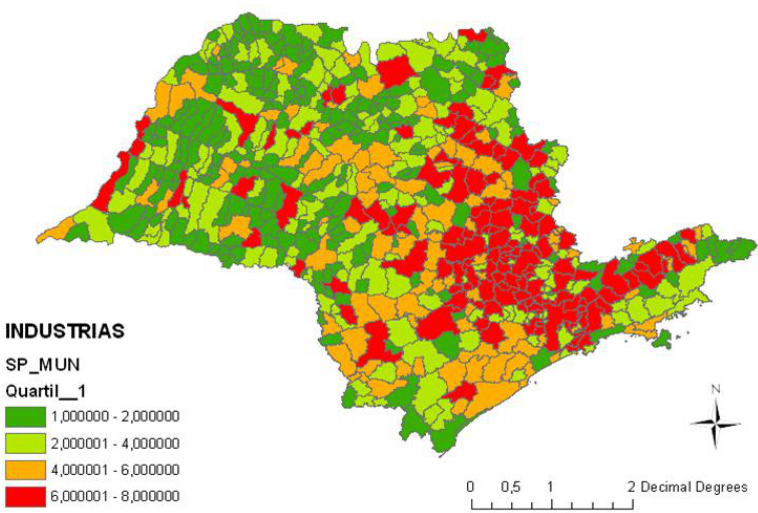
Figure 2. State of Sao Paulo, Brazil—Health risk factors from stationary sources of pollution: industries in the municipality/industries in the State of Sao